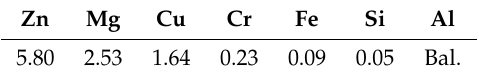
Table 1. Chemical composition of the 7075 aluminum alloy extruded rod (mass %).